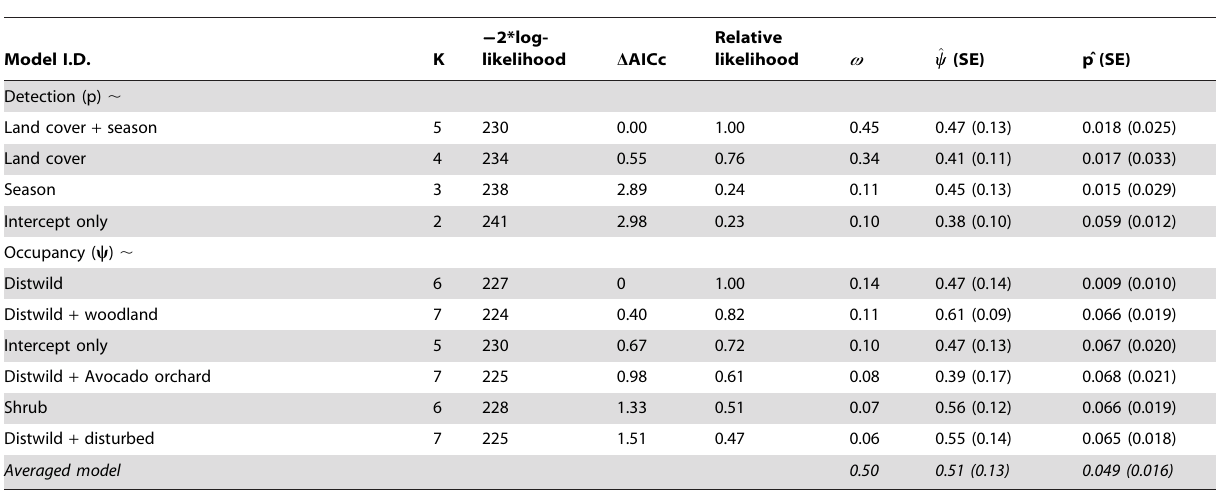
Table 1. Top-ranked models of site occupancy ( y ) and detection rate (p) for gray fox.